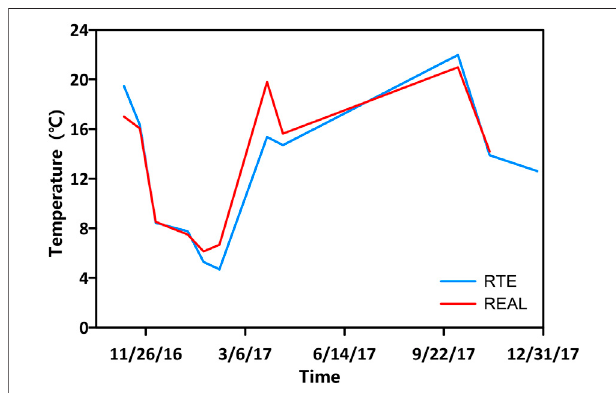
FIGURE 8 | Comparison of experimental results and measured data in the Lao